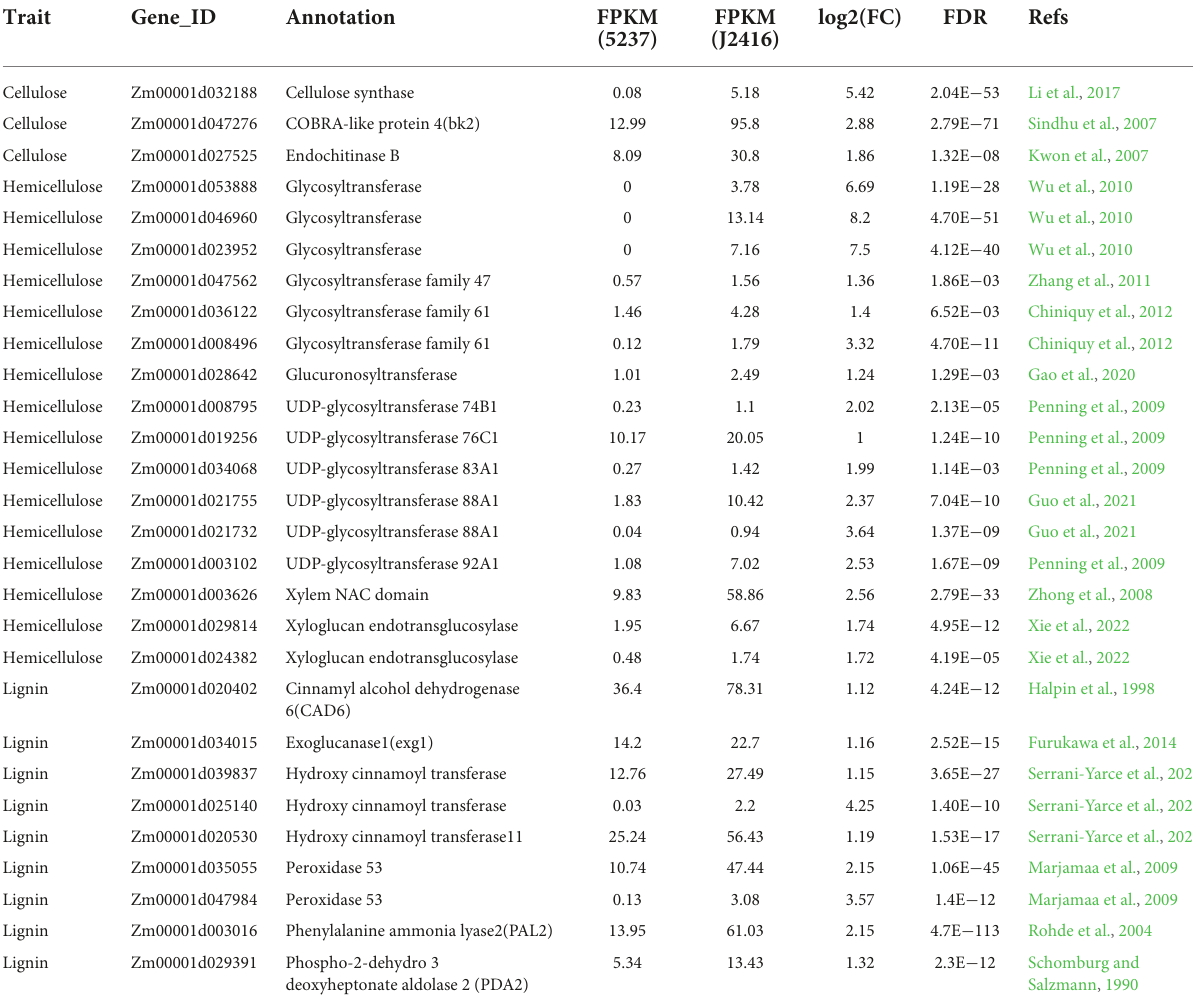
TABLE 1 Up-regulated genes in J2416 related to synthesis of cellulose, hemicellulose, and lignin.